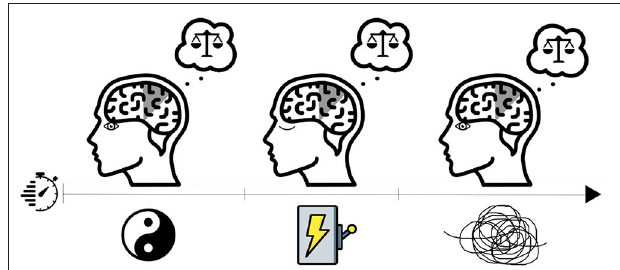
FIGURE 1 | Visual representation of a resting-state baseline condition (left illustration; eyes open) in addition to stimulation stage (eyes closed) and accommodation post-stimulus (right illustration; eyes open). The main interest in the study is to compare the resting-state vs. accommodation post-stimulus.